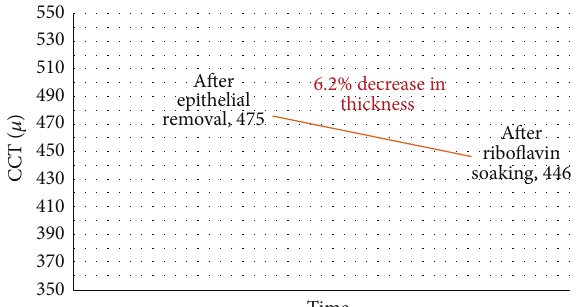
Figure 1: CCT changes (in microns) after riboflavin soaking.